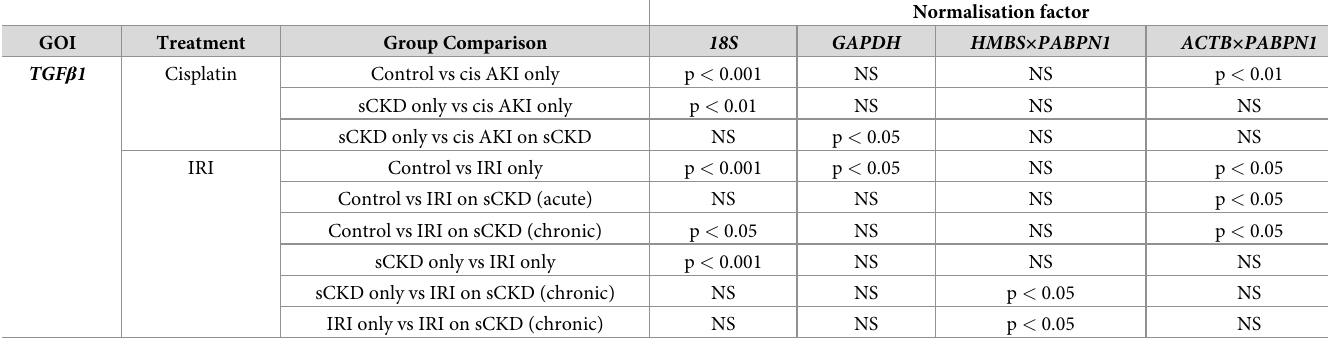
Table 14. Statistical differences of TGF β 1 normalised to different reference genes and reference gene